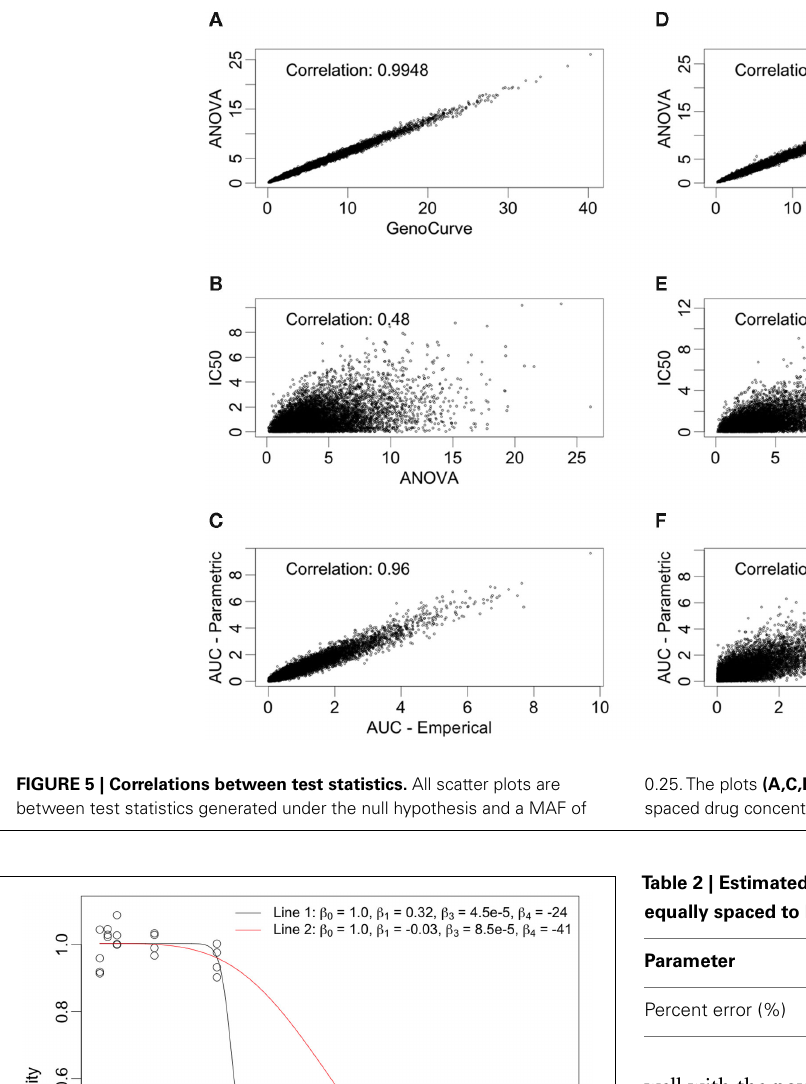
0.25.The plots (A,C,E) are of statistics generated from data with equally spaced drug concentrations, while plots (B,D,F) used log-equally spaced data.